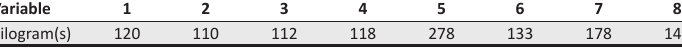
TABLE 3: Collection data from all suppliers for the real problem (kilograms). Variable